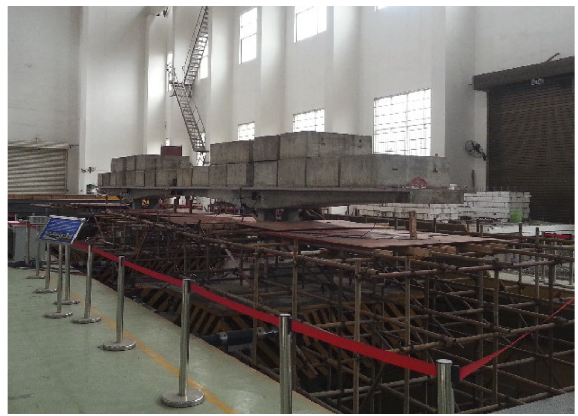
Figure 22: Shake table test with adjacent multispan bridges.